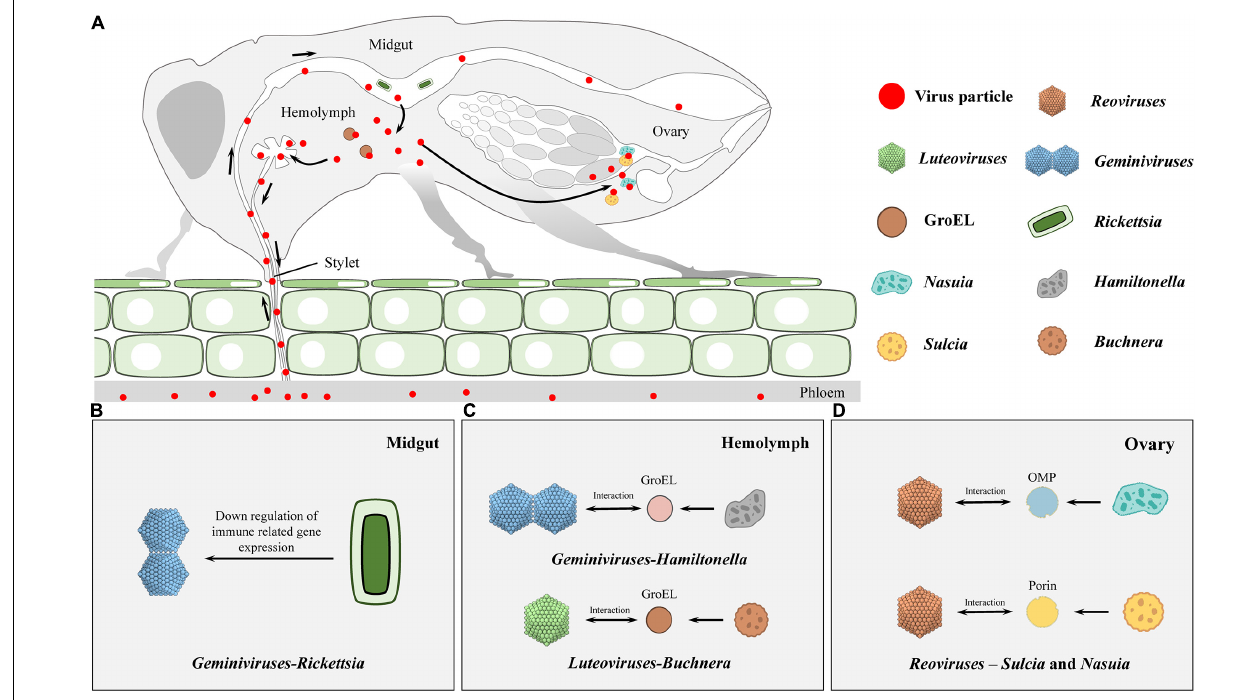
FIGURE 1 | Schematic diagram on infection routes of persistent plant viruses in insect vector. (A) During feeding, viral particles are sucked up together with plant sap proteins and ingested into the gut lumen by the insect vectors. Subsequently, the ingested virions initially infect the intestinal epithelium and transfer across the midgut cellular barriers to the hemolymph. Finally, virions enter into salivary glands to be horizontally transmitted to healthy plants or transfer into the reproductive system, thus being vertically transmitted to offspring. (B,C) In horizontal transmission, Rickettsia in the midgut lumen can benefit geminivirus acquisition, retention, and transmission in the insect (B) . Here, it should be noticed that GroEL-begomovirus/-luteovirus interaction is essential for the stability of the virus in hemolymph, otherwise the insect immune system may recognize and degrade these foreign invaders (C) . (D) During the process of vertical transmission, Reovirus virions migrate to the ovaries and enter the eggs by hitchhiking on the envelopes of Sulcia and Nasuia , and they benefit from the vertical transmission routes taken by the two obligate bacterial symbiont partners in females.